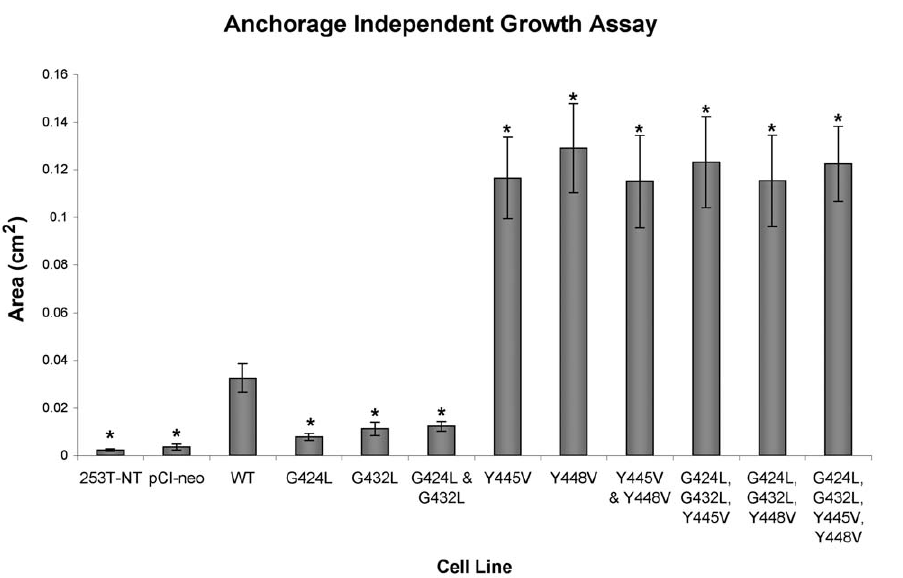
Figure 6. Size Distribution of Soft Agar Colonies. Image ProPlus software was used to calculate the average area of soft agar colonies. The results represent three separate soft agar growth experiments. The columns marked with an asterisk indicate sublines that were either significantly smaller or larger than those formed by cells transfected with wild type (WT) CEACAM1-4S (p , 0.05). doi:10.1371/journal.pone.0029606.g006 PLoS ONE |